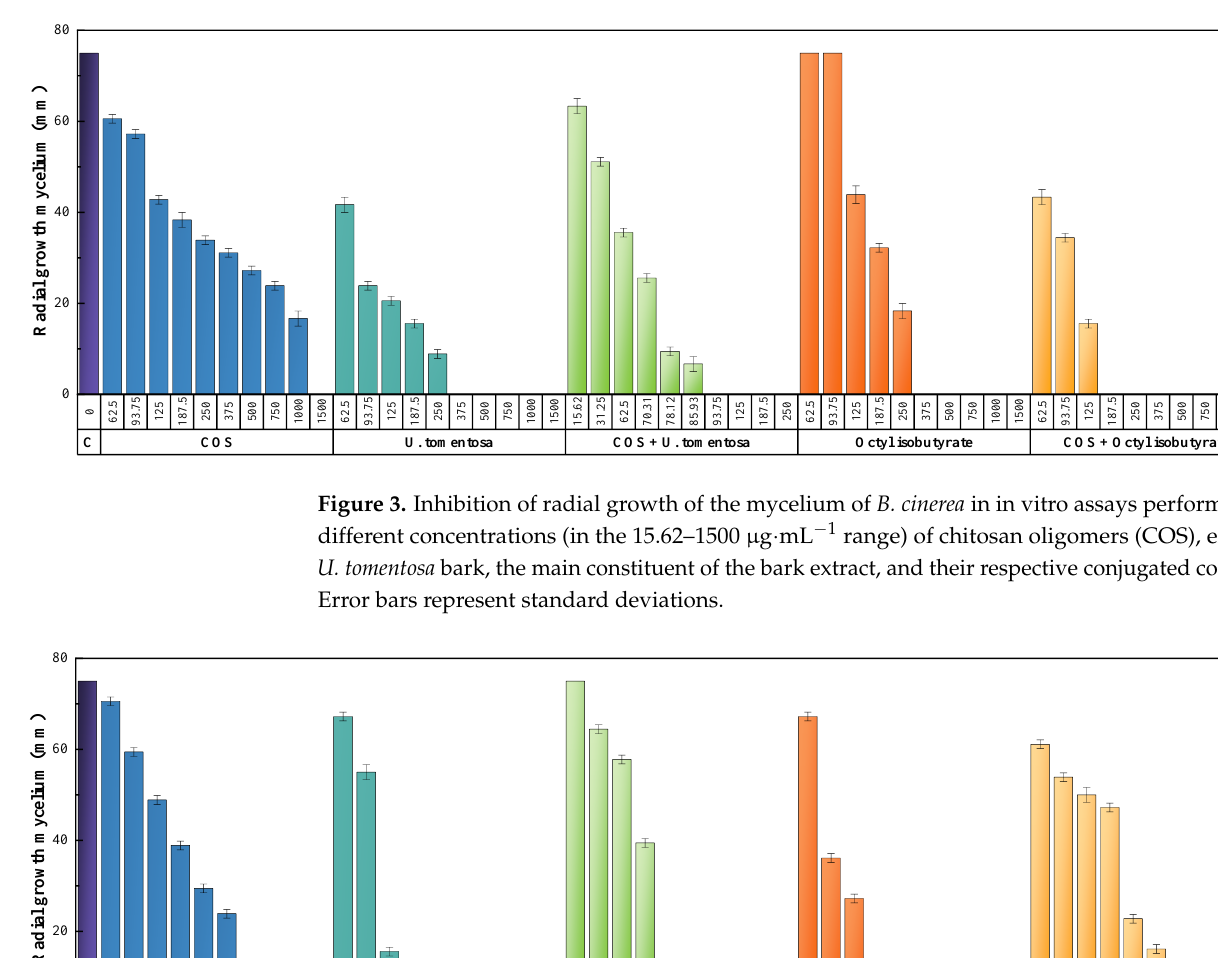
Figure 3. Inhibition of radial growth of the mycelium of B. cinerea in in vitro assays performed with different concentrations (in the 15.62 – 1500 µg·mL −1 range) of chitosan oligomers (COS), extract of U. tomentosa bark, the main constituent of the bark extract, and their respective conjugated com- plexes. Error bars represent standard deviations.